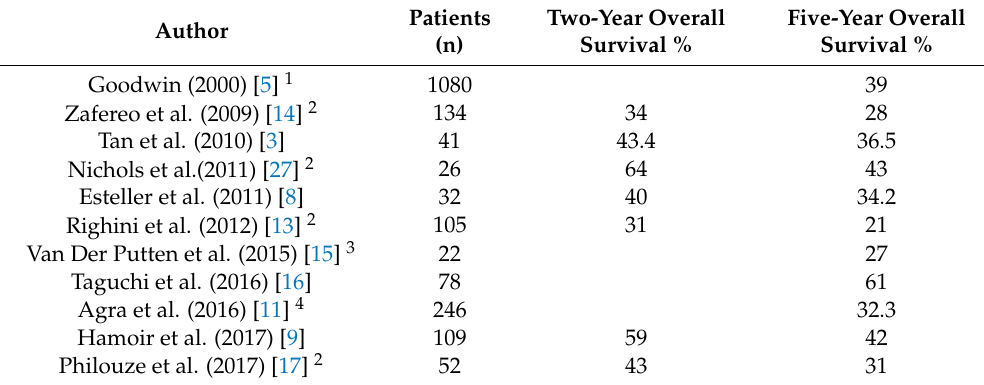
Table 1. Reported overall survival rates in recent series of patients who had salvage surgery for recurrent head and neck squamous cell